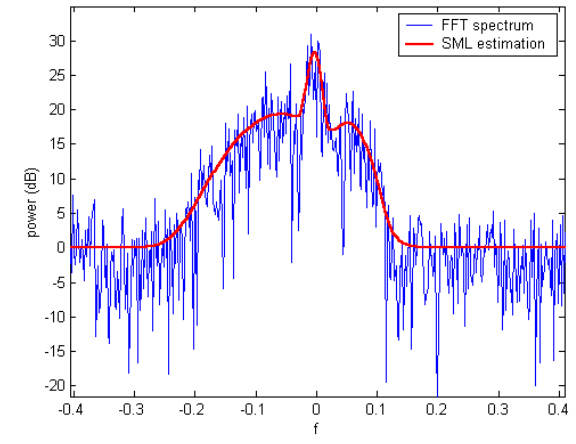
Fig. 2. SML estimation of 3 strongly overlapped Gaussian echoes